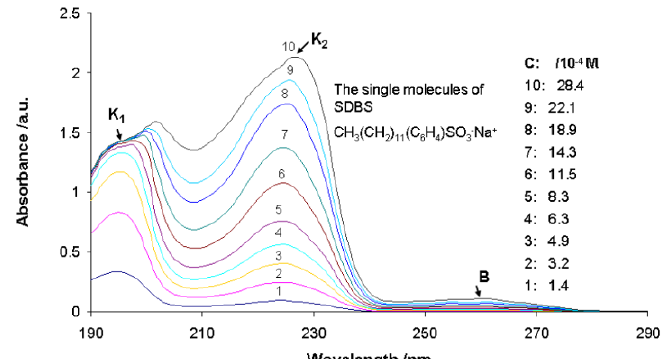
Figure 1. UV-Vis Absorption spectra of SDBS in dilute aqueous solutions with concentrations used for the series of measurements.